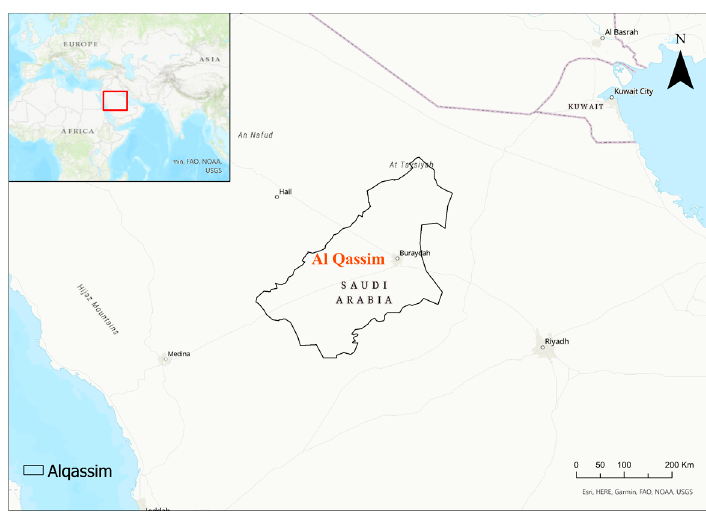
Figure 1. Al-Qassim region located in the center of Saudi Arabia.